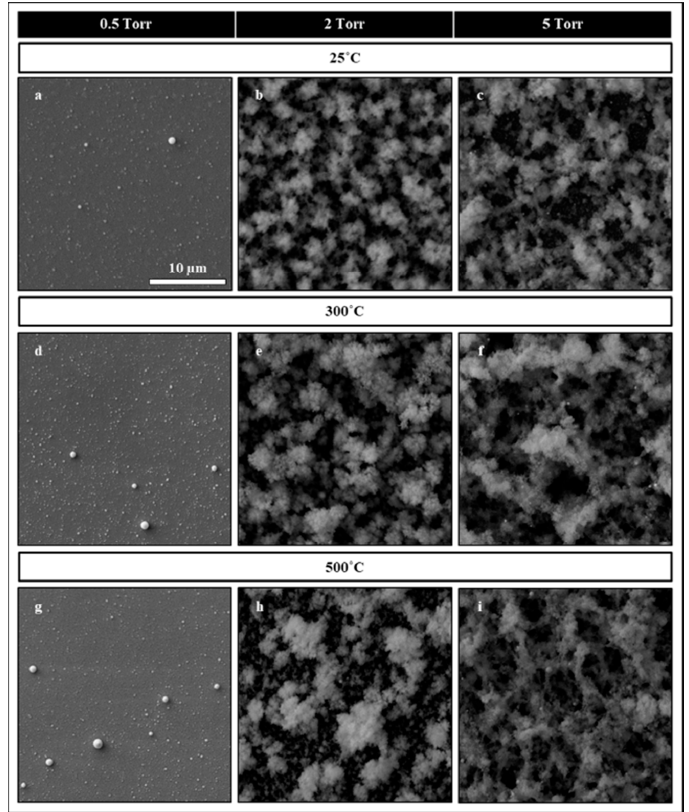
Figure 2. Scanning Electron Microscopy (SEM) Images of ensemble nanoparticles deposited at 0.5 ( a , d , g ), 2 ( b , e , h ), and 5 torr ( c , f , i ). The baking temperature e ff ects on the morphology of the nanoparticles ensembles for di ff erent pressure conditions are shown for room temperature ( a – c ), 300 ◦ C ( d – f ), and 500 ◦ C ( g – i ). The deposition morphology shows a denser film at 0.5 torr and becomes more mesoporous at higher pressures. Temperature treatments of the samples resulted in the crystallization and sintering of the nanoparticles and the formation of a larger blub of nanoparticles. All images are on the same scale